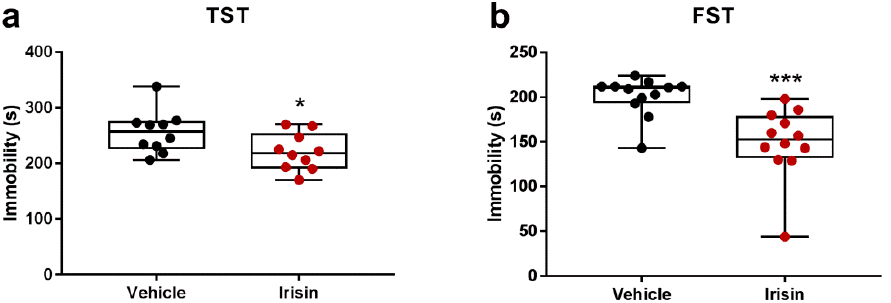
Figure 3. Effect of short-term systemic administration of irisin on the immobility time in the TST ( a ) and in the FST ( b ). Shapiro–Wilk test was followed by unpaired two-tailed Student’s t -test for the TST and unpaired Mann–Whitney test for the FST. Data are presented as box-and-whisker with median and interquartile ranges, from max to min, with all data points shown. n = 10 vehicle-treated mice and n = 10 irisin-treated mice for TST. n = 12 vehicle-treated mice and n = 12 irisin-treated mice for FST. * p < 0.05; *** p < 0.0001. Table 1. Immobility time results in the TST and the FST after short-term and long-term irisin ad- ministration.